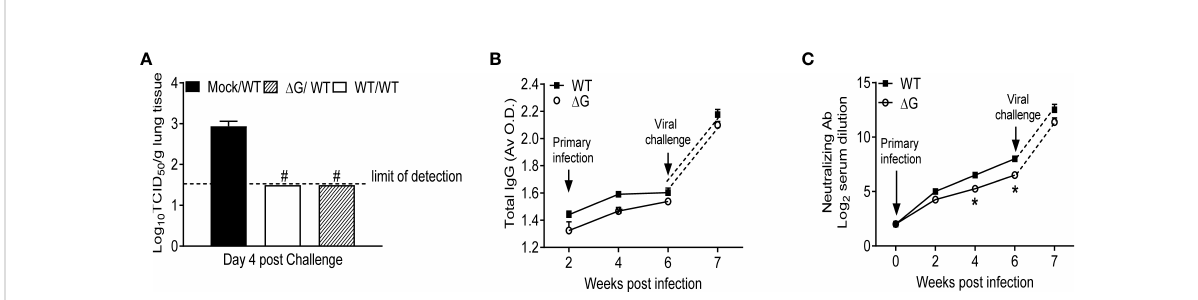
FIGURE 6 Virus replication and antibody titer in response to virus challenge. Mock and previously rhMPV-WT or - D G infected mice were challenged with rhMPV-WT virus 6 weeks after primary infection. (A) Mice were sacri fi ced on day 4 post challenge (peak of viral replication), and lungs were harvested for determining viral titers by TCID 50 assay. (B) Total hMPV-speci fi c IgG titers in serum were determined by ELISA. (C) hMPV-speci fi c neutralizing antibody titer was determined by plaque neutralization assay. Data are expressed as mean ± SEM of four animals/group and is representative of one of two independent experiments. *P<0.05 when comparing rhMPV-WT and - D G; # P<0.05 when comparing rhMPV-WT and - D G and mock- mice challenged with rhMPV -WT. rhMPV - D G = D G; rhMPV -WT = WT; Mock/rhMPV -WT = Mock/W; rhMPV - D G/rhMPV –